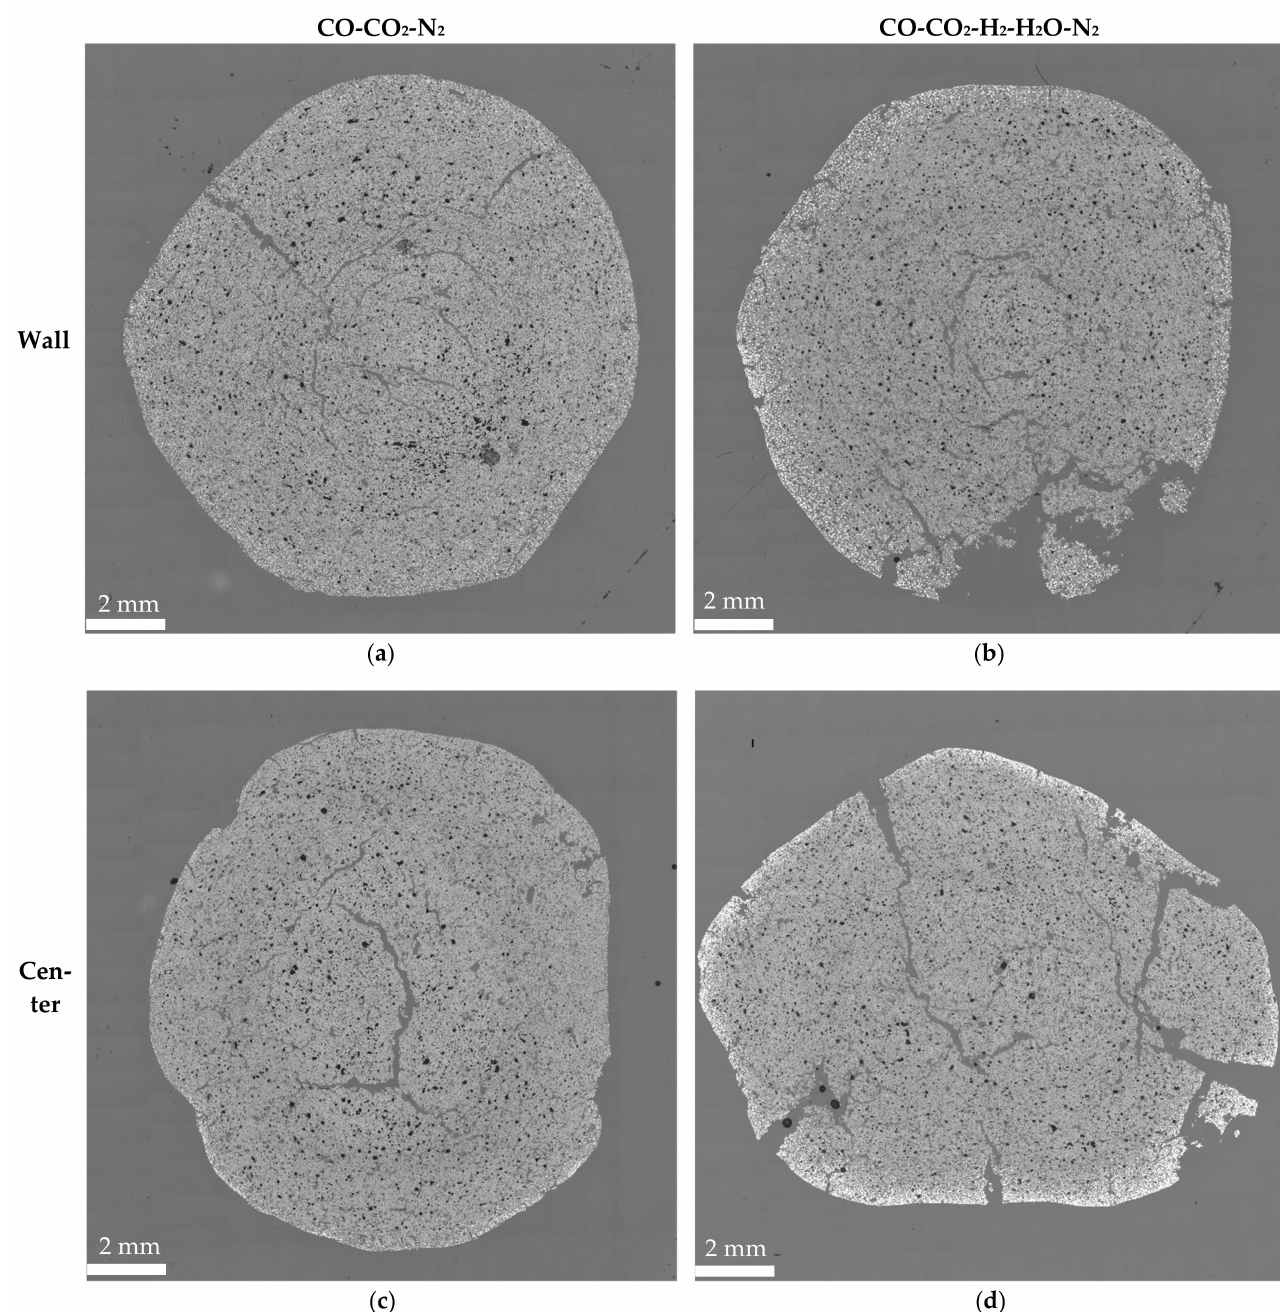
Figure 13. Pellet cross-sections after non-isothermal reduction, using ( a ) the wall profile in CO-CO 2 - N 2 gas, ( b ) the wall profile in CO-CO 2 -H 2 -H 2 O-N 2 gas, ( c ) the center profile in CO-CO 2 -N 2 gas, and ( d ) the center profile in CO-CO 2 -H 2 -H 2 O-N 2